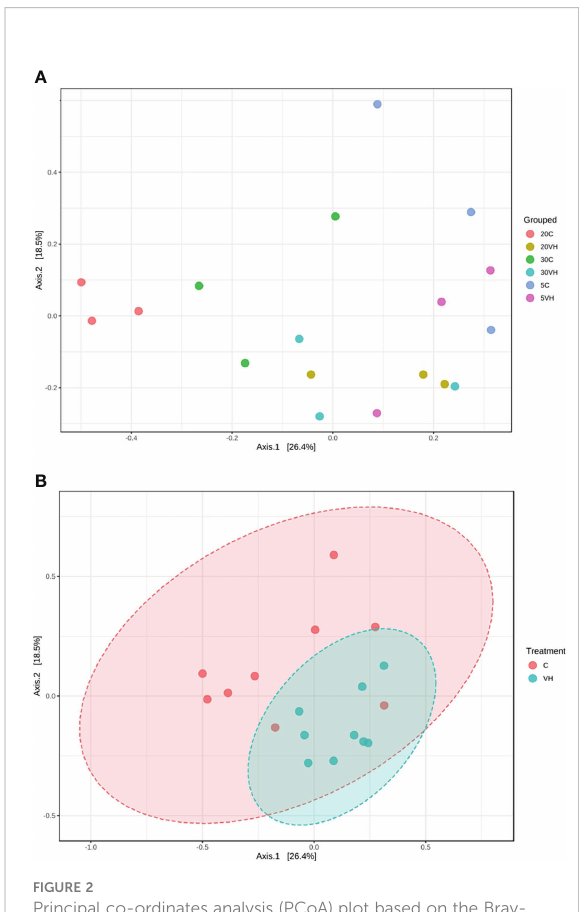
FIGURE 2 Principal co-ordinates analysis (PCoA) plot based on the Bray- Curtis dissimilarities of bacterial community structures of the Litopenaues vannamei cultured at different salinity levels and challenged with Vibrio harveyi , (A) Comparison of bacterial community between all treatment groups and (B) Comparison of bacterial community between C and VH group. (VH, Vibrio harveyi infected group and C, Control group; 5, 5 ppt; 20, 20 ppt and 30, 30 ppt).